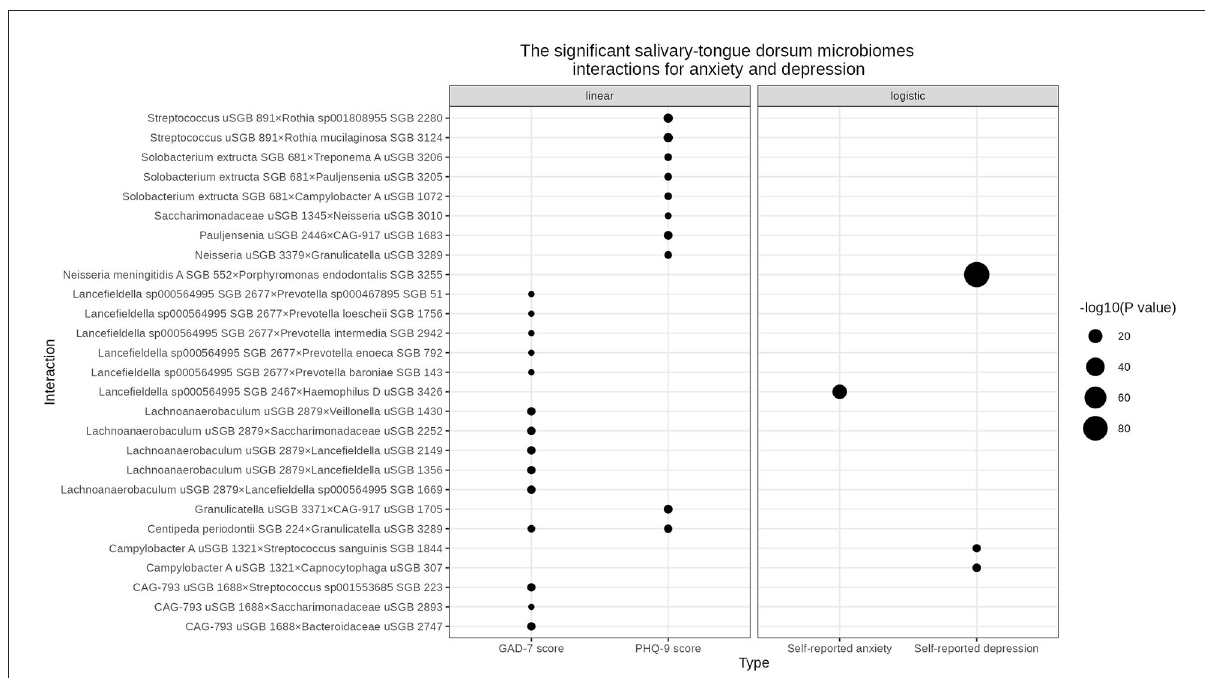
FIGURE1 The significant salivary-tongue dorsum microbiome interactions for anxiety and depression. The bubble chart represents the significant salivary-tongue dorsum microbiome interactions for anxiety and depression in the linear regression model and logistic regression model, respectively. Circle size indicates the -log10 (P value) of each interaction.